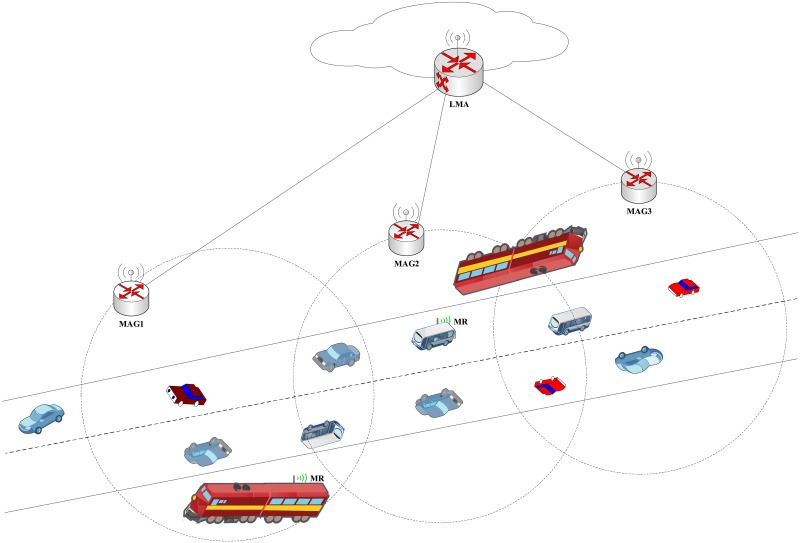
System architecture.